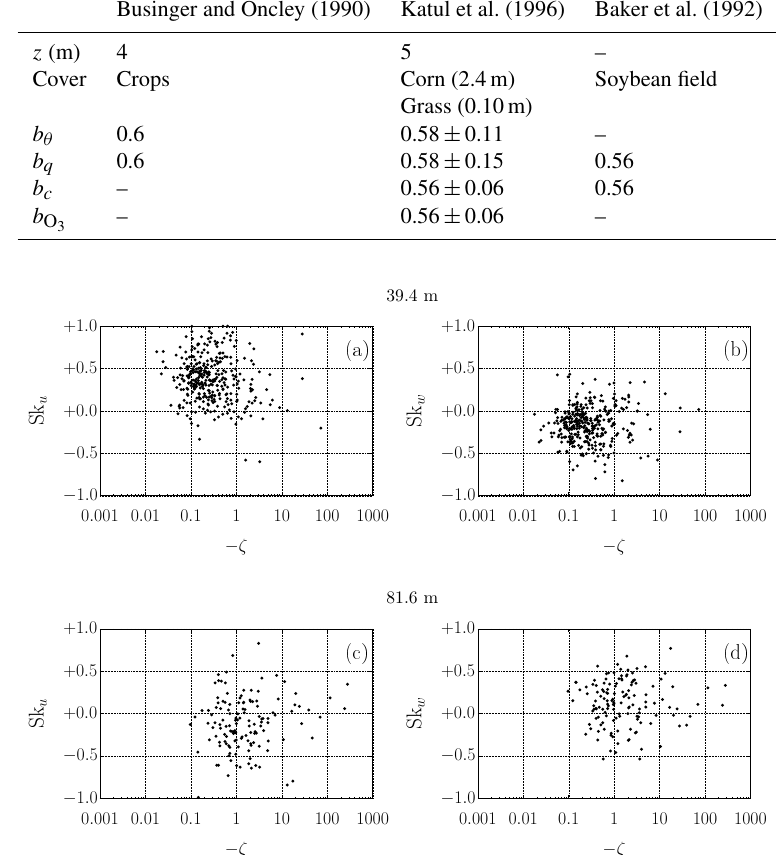
Figure 2. Horizontal (Sk u ) and vertical (Sk w ) velocity skewness: (a) Sk u at 39.4m; (b) Sk w at 39.4m; (c) Sk u at 81.6m; and (d) Sk w at